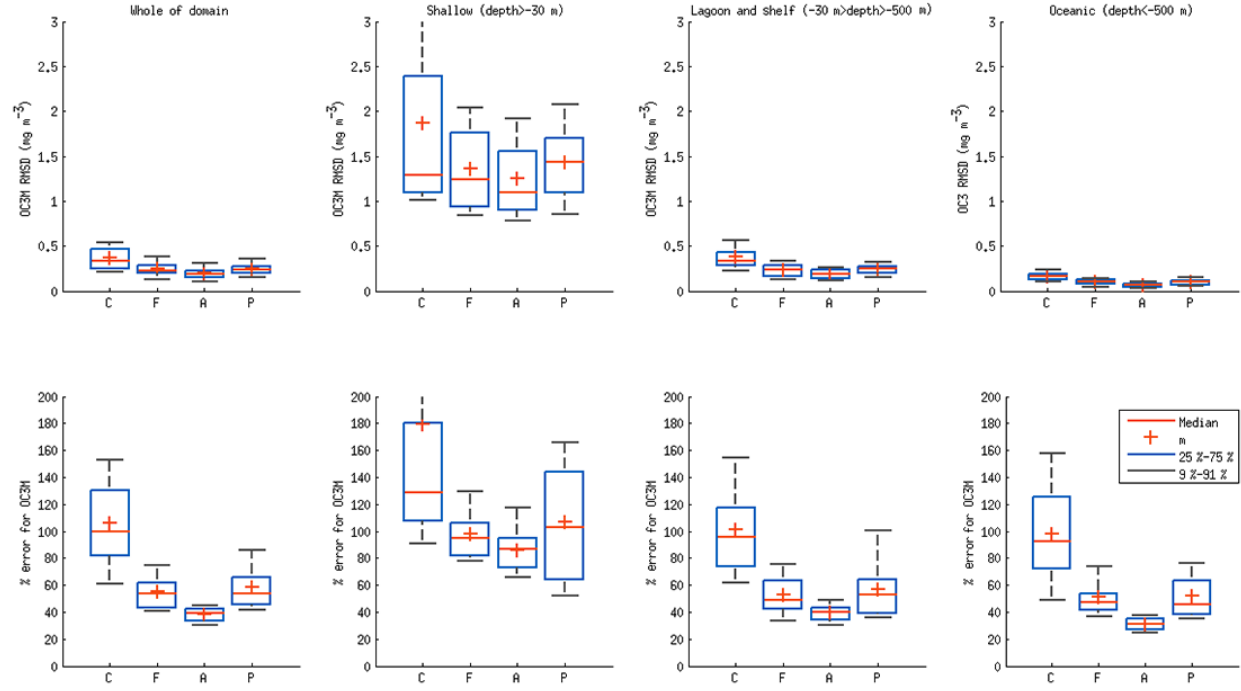
Figure 12. Box and whisker plots of RMSD (top row) and MAPE (bottom row) of the mismatch between simulated OC3M and ANN- corrected observed OC3M. Each panel contains the control run (C) and EXP4 showing forecast (F), persistence (P) and analysis (A). Presented are statistics for the whole domain (left column) and regions as defined by bottom depth (three rightmost columns), for which the mean and range of values are presented in Tables 2 and